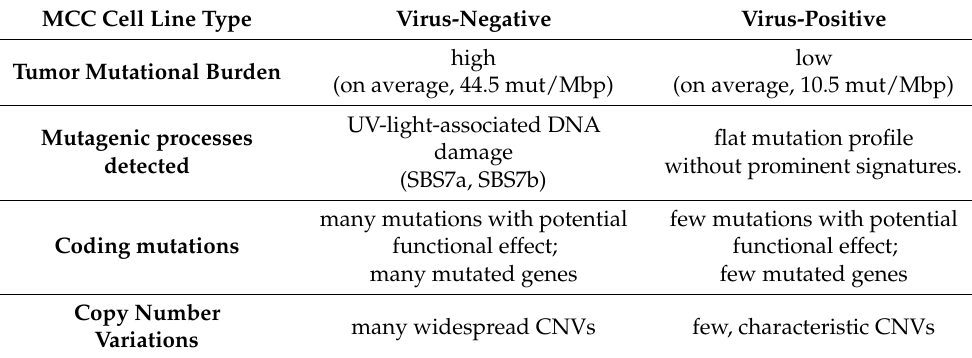
Table 1. Genomic features of MCC cell lines for both MCC